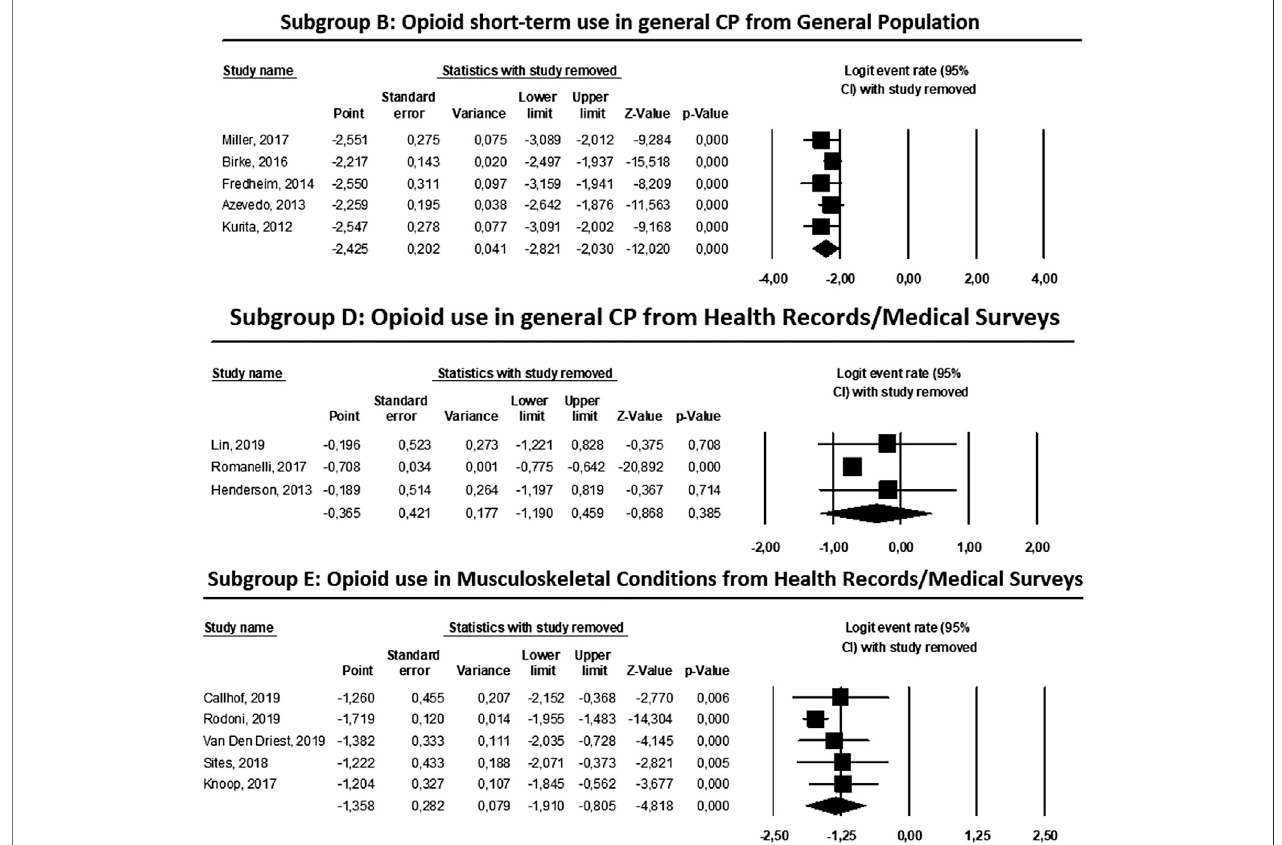
FIGURE 4 | In fl uence graphics for sensibility analysis of the subgroups B, D and E of the meta-analyses.